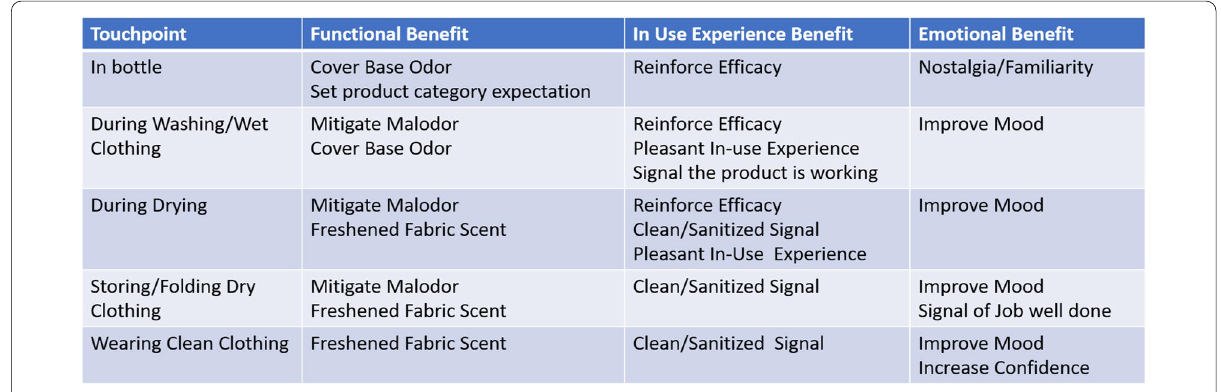
Fig. 3 Scent benefits framework as experienced across a laundry touchpoint